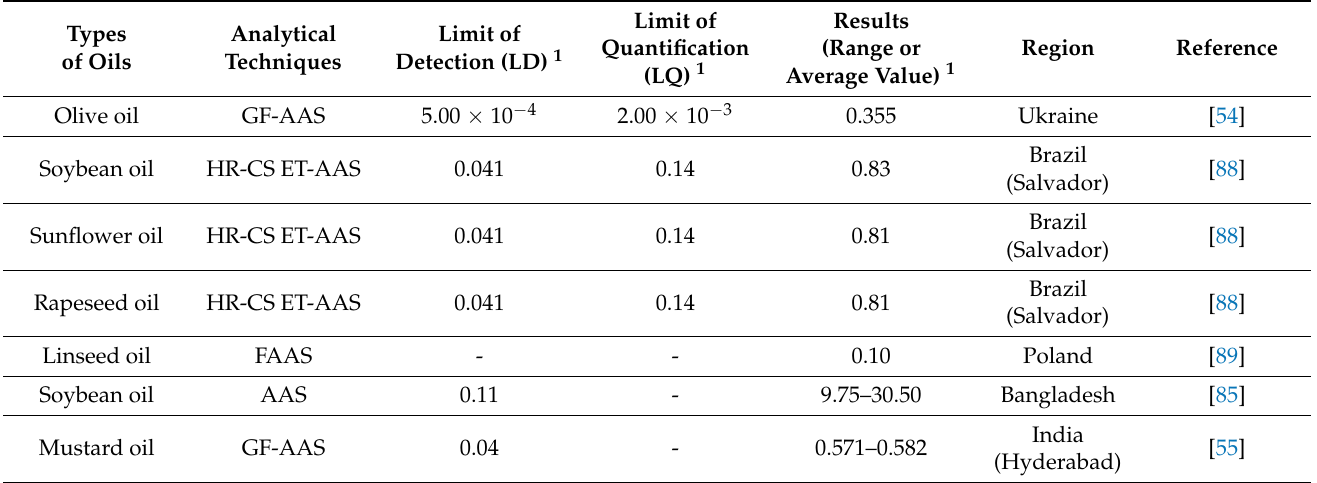
Table 5. Copper (Cu) content in edible vegetable oils, expressed in